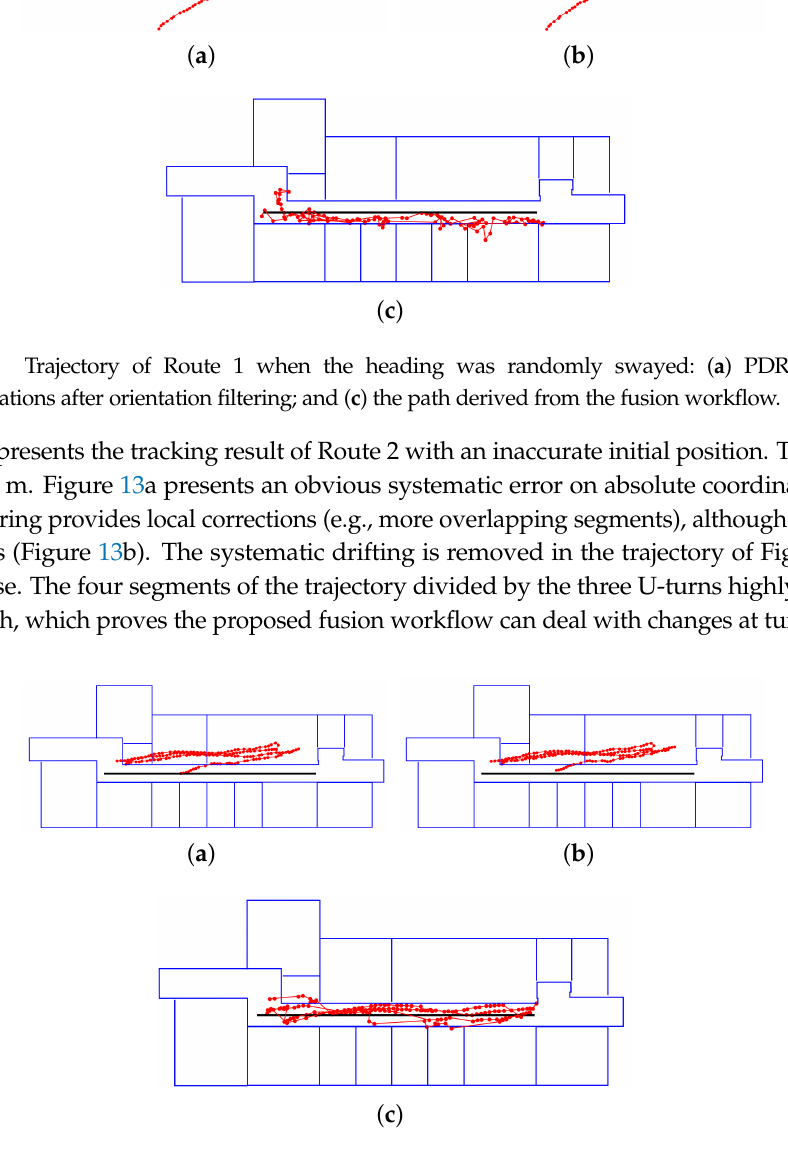
Figure 13. Trajectory of Route 2 with an inaccurate initial position: ( a ) PDR locations; ( b ) PDR locations after orientation filtering; and ( c ) the path derived from the fusion